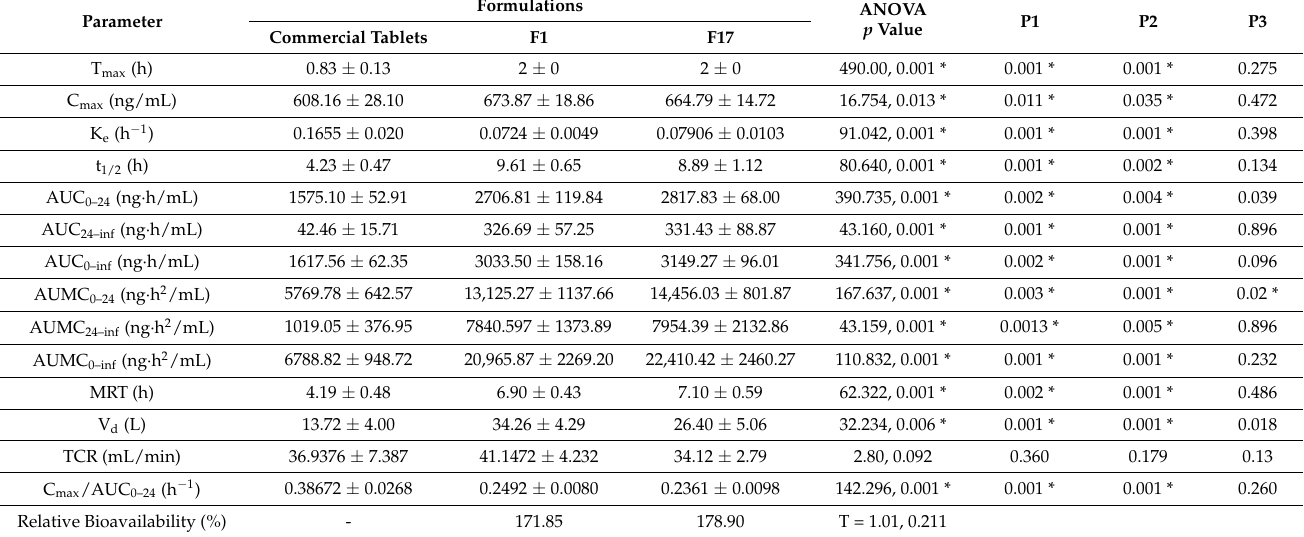
Table 4. ANOVA analysis of the pharmacokinetic parameters of the 3 studied groups (commercial tablet, F1, and F17) and a comparison between the 3 groups using Tukey–Kramer multiple comparison test.